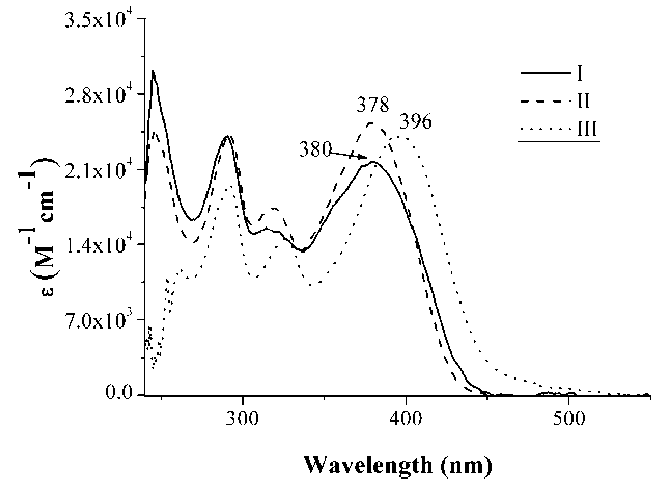
Figure 1. Molar absorptivity of compounds I , II , and III .